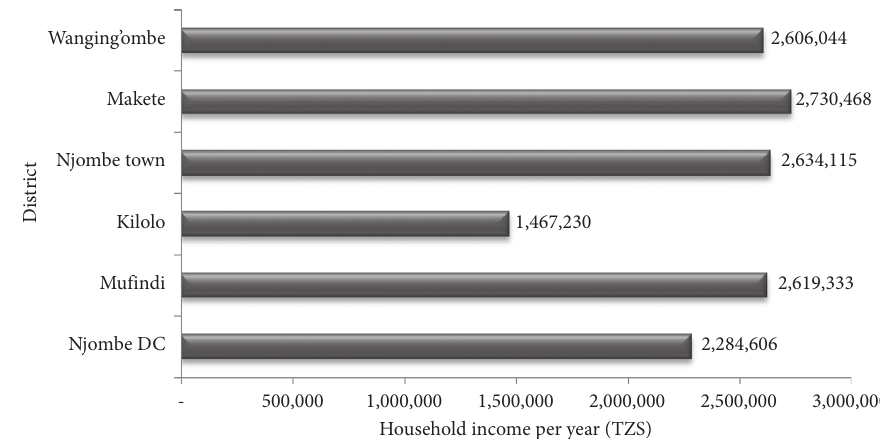
Figure 5: Household income from non-tree farming activities (source: own field data).